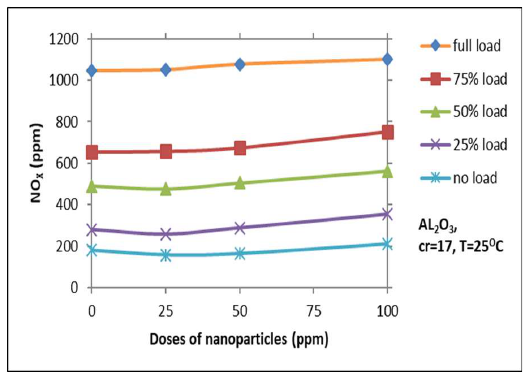
Fig. 7. Variation of Carbon dioxide Emissions (CO 2 ) with Titanium nanoparticles